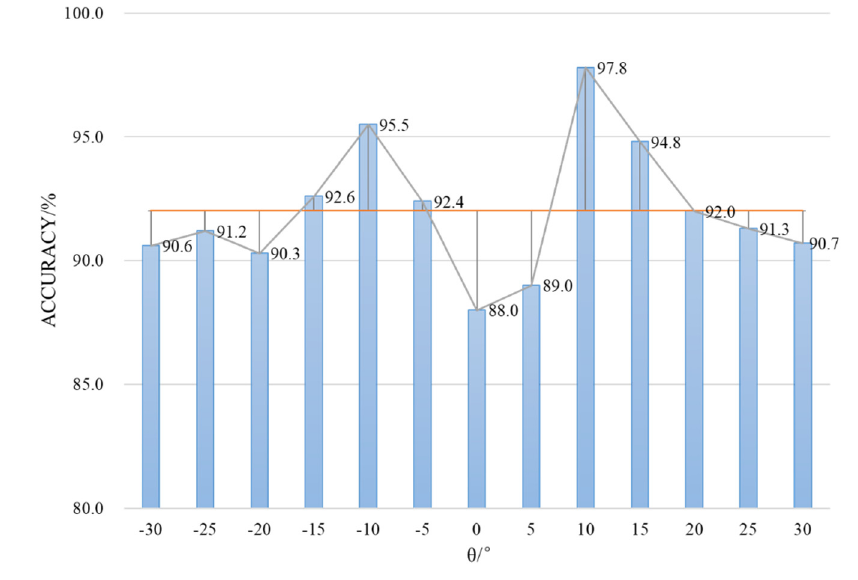
ff erent camera pan